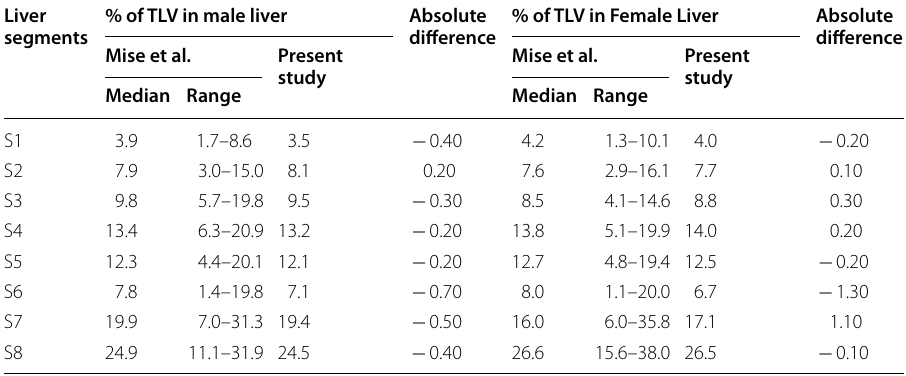
Table 1 PTLV values from a reference study reported by Mise et al. [22] and from the segmentation performed in the MRCP AFL/AML (present study) Liver % of TLV in male segments